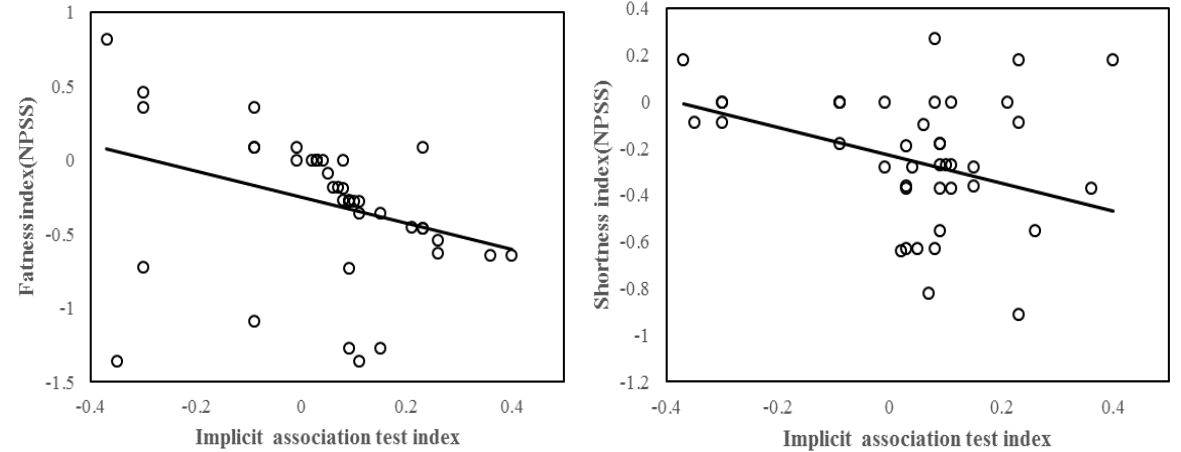
Figure 3. ( Left panel ), negative correlation between IAT (post − pre) and fatness index (a component of negative physical self scale). ( Right panel ), negative correlation between IAT (post − pre) and shortness index (also a component of negative physical self scale). Table 5. Predictive role of IAT (post-pre).